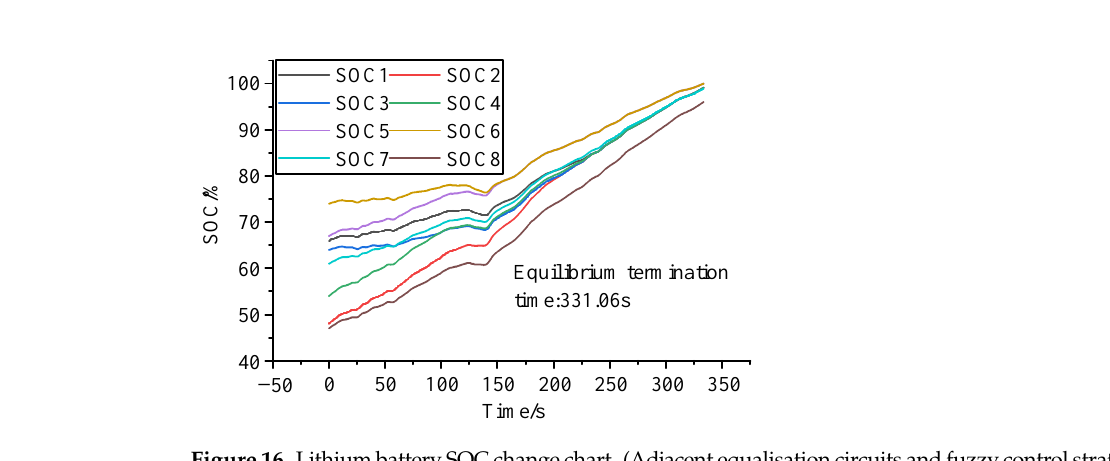
Figure 16. Lithium battery SOC change chart. (Adjacent equalisation circuits and fuzzy control strategies).